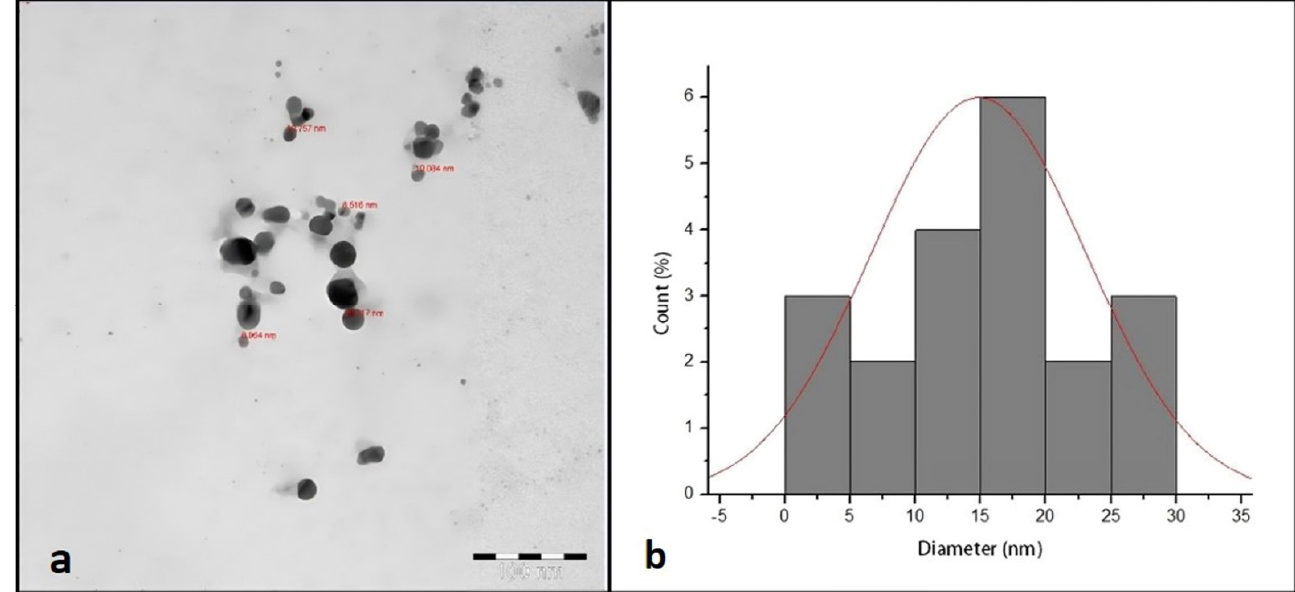
Figure 2. TEM image of synthesized AgNPs ( a ). TEM size distribution of synthesized AgNPs ( b ).